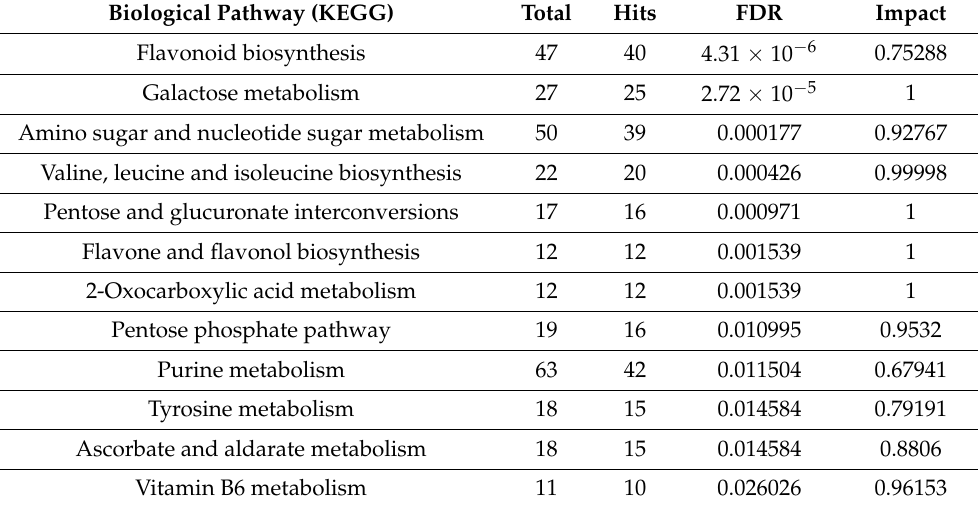
Table 1. The most represented metabolic pathways based on pathway enrichment analysis performed with all MS signals detected in Brachypodium roots, leaves and spikes. KEGG—Kyoto Encyclopedia of Genes and Genomes [37]; total—number of compounds included in biological pathway in the database; hits—number of compounds matched in our analysis; FDR—false discovery rate; impact— pathway impact value related to the number of links occurred upon a node in pathway topology graph. Full set of data including other pathways as well as lists of annotated metabolites is available as Supplementary Table